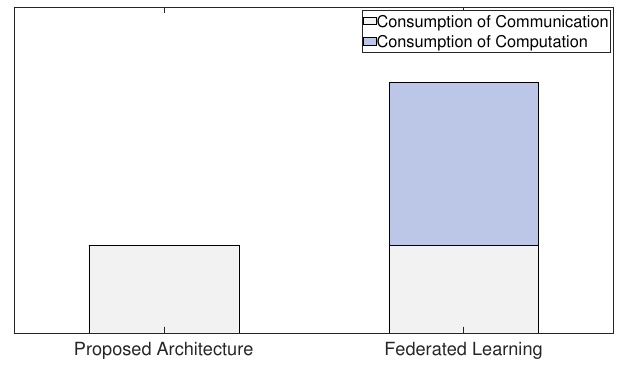
Figure 4. Power consumption of client compare between our system model and standard federated learning. Battery consumption of the client caused by local update computation could be reduced in our system model.